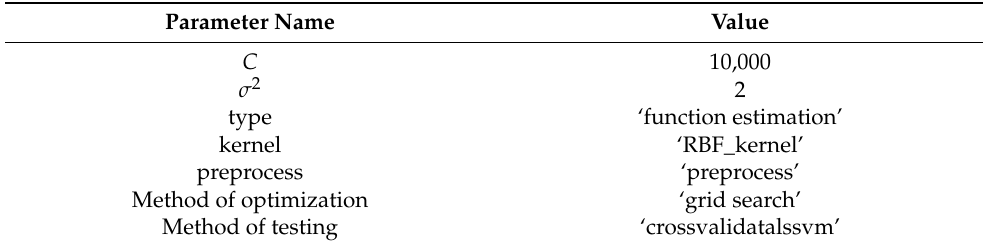
Table 1. Initial parameters setting of the LSSVM